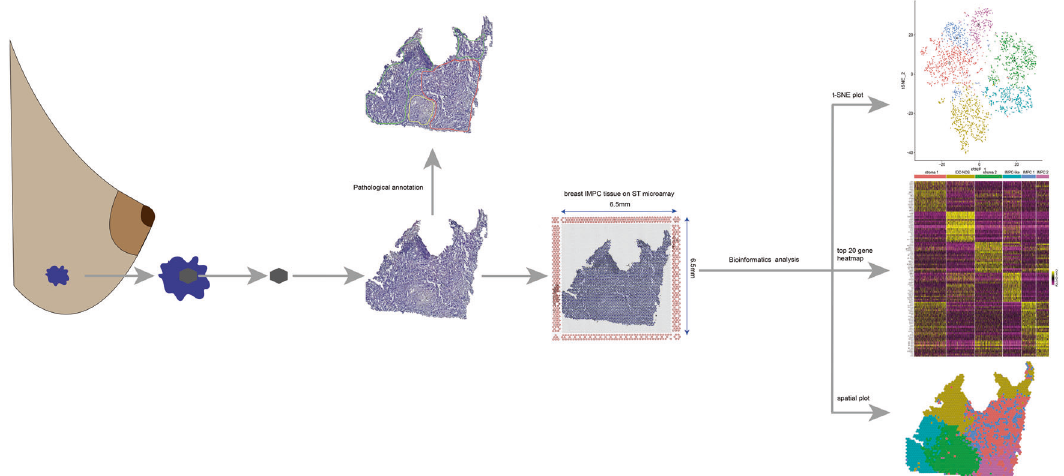
Fig. 1 The work fl ow for spatial transcriptomics (ST) and hierarchical clustering results. Attached a 10 µm thick tissue to the slide for ST sequencing, performed bioinformatics analysis on the sequencing data, and displayed the hierarchical clustering results with t-SNE, heatmap, and spatial